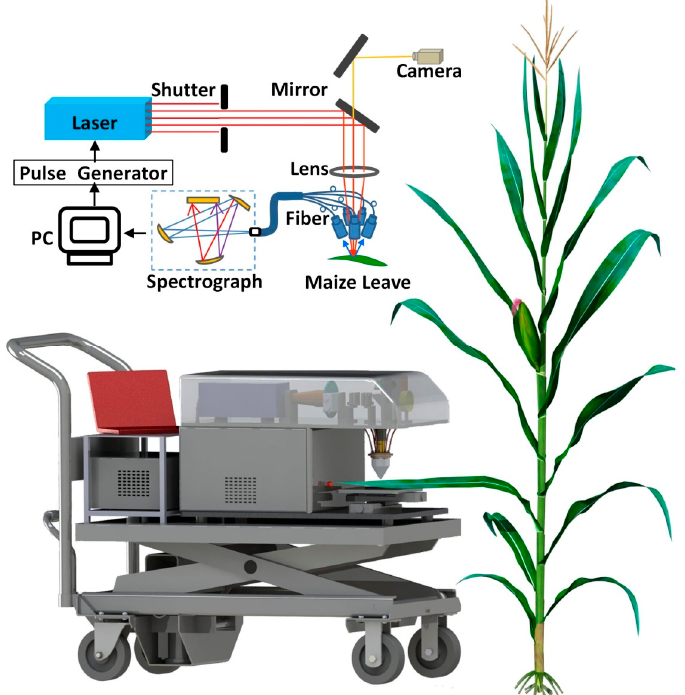
Figure 1. Schematic of the LipsImag apparatus and its application for in situ and in vivo elemental mapping of maize.